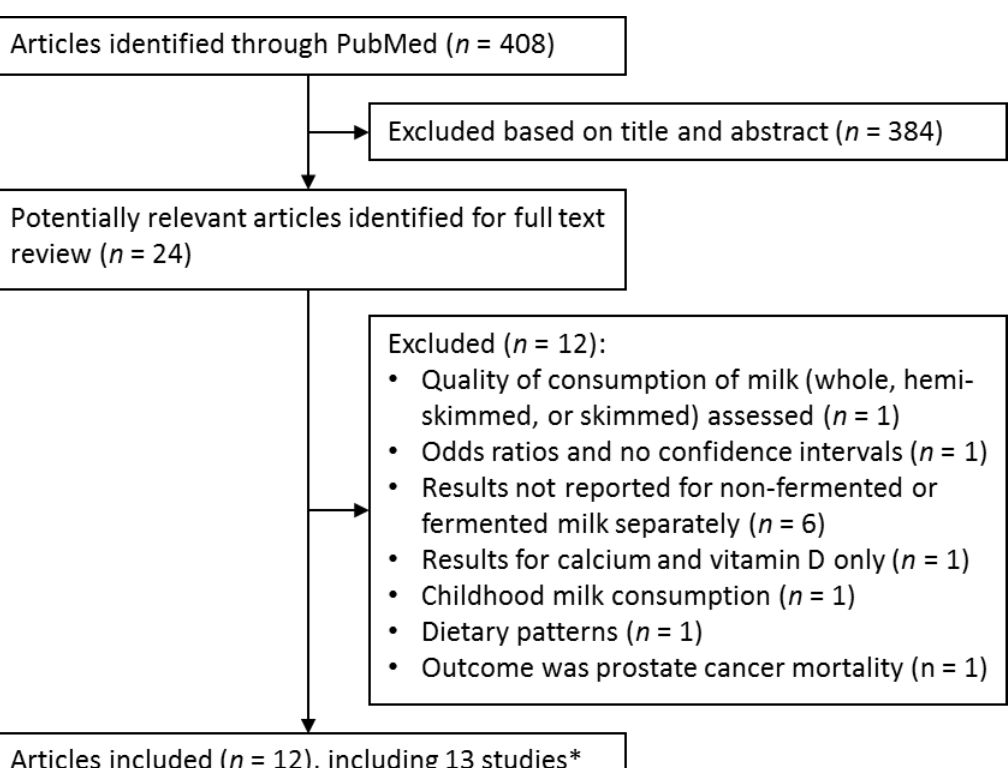
Figure 1. Flow diagram of literature search and study selection. Studies excluded based on